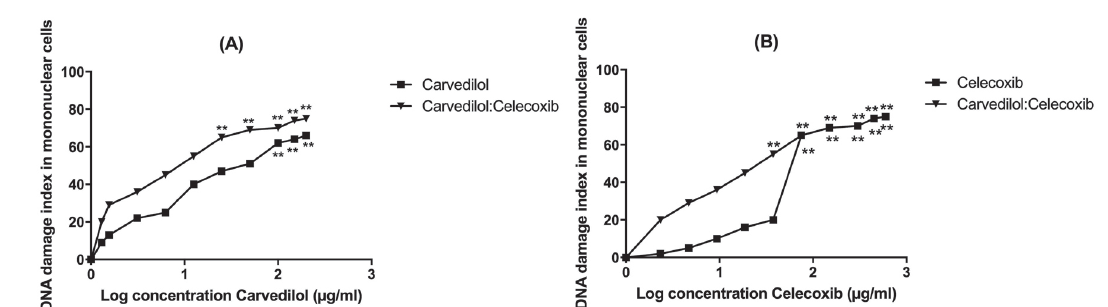
FIGURE 2 - DNA damage index of carvedilol, celecoxib and their combination (carvedilol:celecoxib) in peripheral blood mononuclear cells (PBMCs) measured by Single Cell Gel Electrophoresis, (A) comparison of DNA damage index after carvedilol and combination (B) comparison of DNA damage index after celecoxib and combination. The graphs shows that the DNA damage induced after treatment with carvedilol and combine concentrations were significant. Nevertheless DNA damages induced by >75 µg/mL of celecoxib were also genotoxic when used alone and combinations. Each Value represent of mean three replicates (n=3). The asterisk indicate significant difference at **p<0.01 between